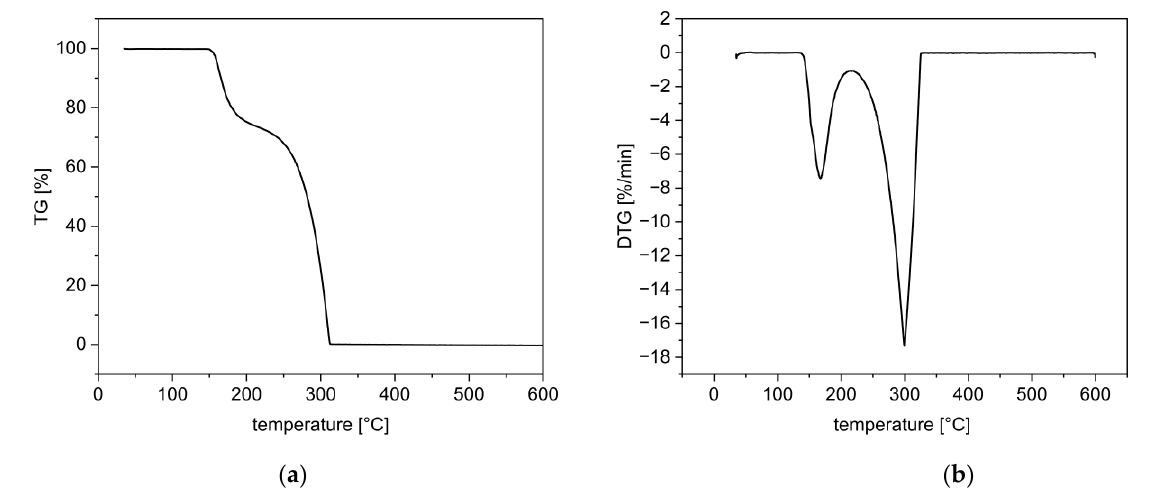
Figure 6. TG ( a ) and DTG curves ( b ) of enalapril